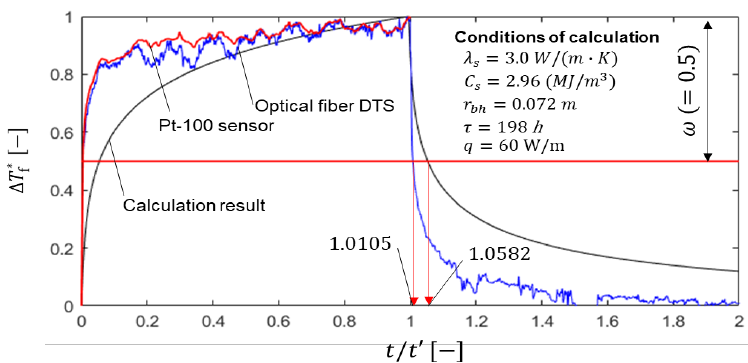
Figure 6. Dimensionless temperature variation and the RTT of the measurement data and the calculated results.